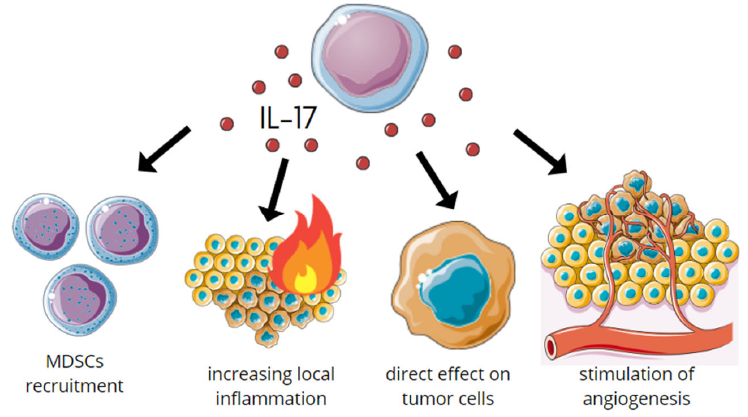
Figure 1. Multidirectional action of IL ‐ 17 in the early stages of tumorigenesis. However, studies have indicated that the IL ‐ 17 knockout contributes to a more aggressive metastatic picture, which may be related to the loss of the potent antitumor cytokine IFN ‐ gamma [24]. It has been shown that IL ‐ 17A directly inhibits the growth of P815 mastocytoma and J558L plasmacytoma [27,28]. There is also known evidence that IL ‐ 17A may exert an indirect pro ‐ apoptotic effect. It was found that IL ‐ 17A, by increasing